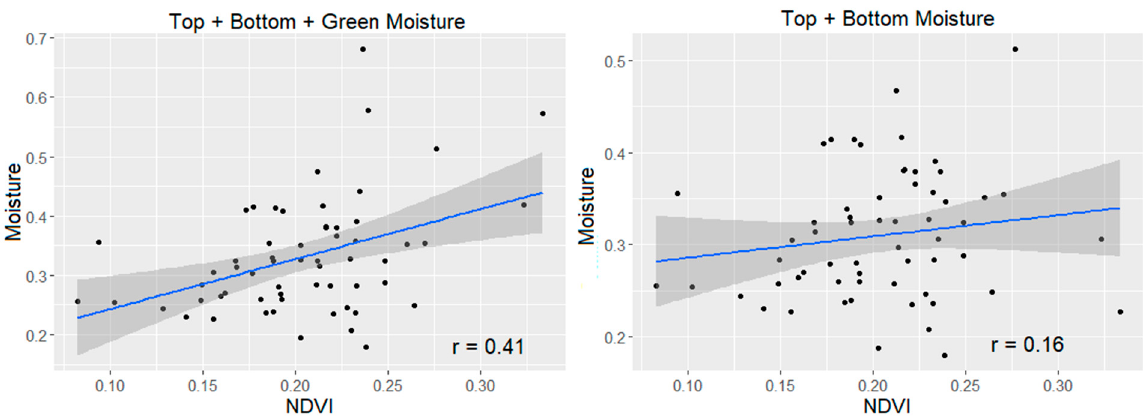
Figure 6. Comparison of the Relationship Between NDVI and Various Moisture Metrics for Short Grass.